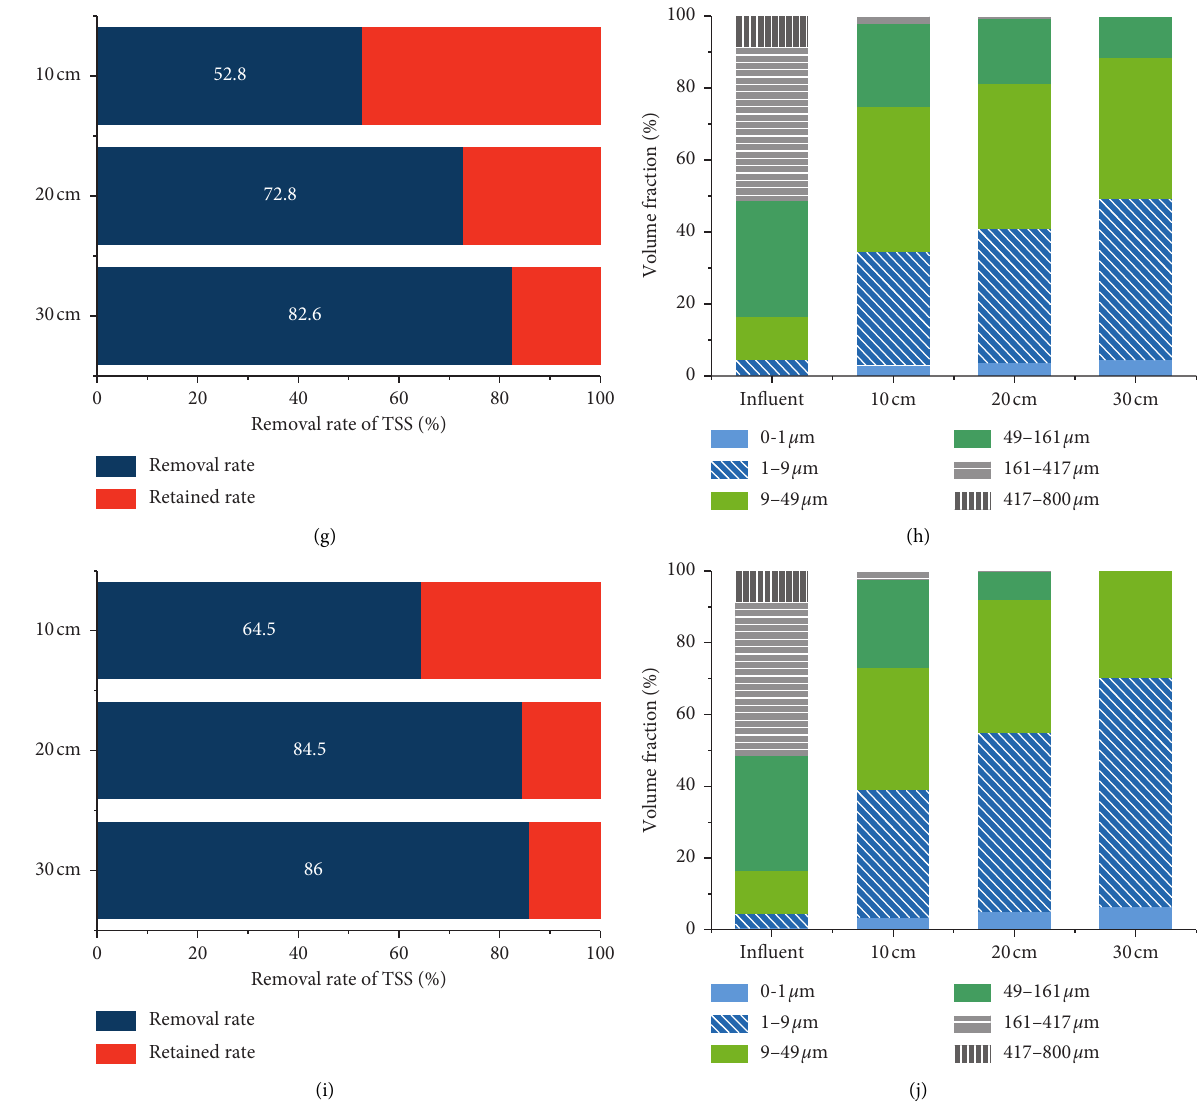
Figure 5: Effect of layer thickness on particle removal efficiency of different filter media. (a) TSS removal rate (Zeolite). (b) PSD based on subdivided intervals (Zeolite). (c) TSS removal rate (Ceramsite). (d) PSD based on subdivided intervals (Ceramsite). (e) TSS removal rate (Slag). (f) PSD based on subdivided intervals (Slag). (g). TSS removal rate (Diatomite). (h) PSD based on subdivided intervals (Diatomite). (i). TSS removal rate (Vesuvianite). (j) PSD based on subdivided intervals